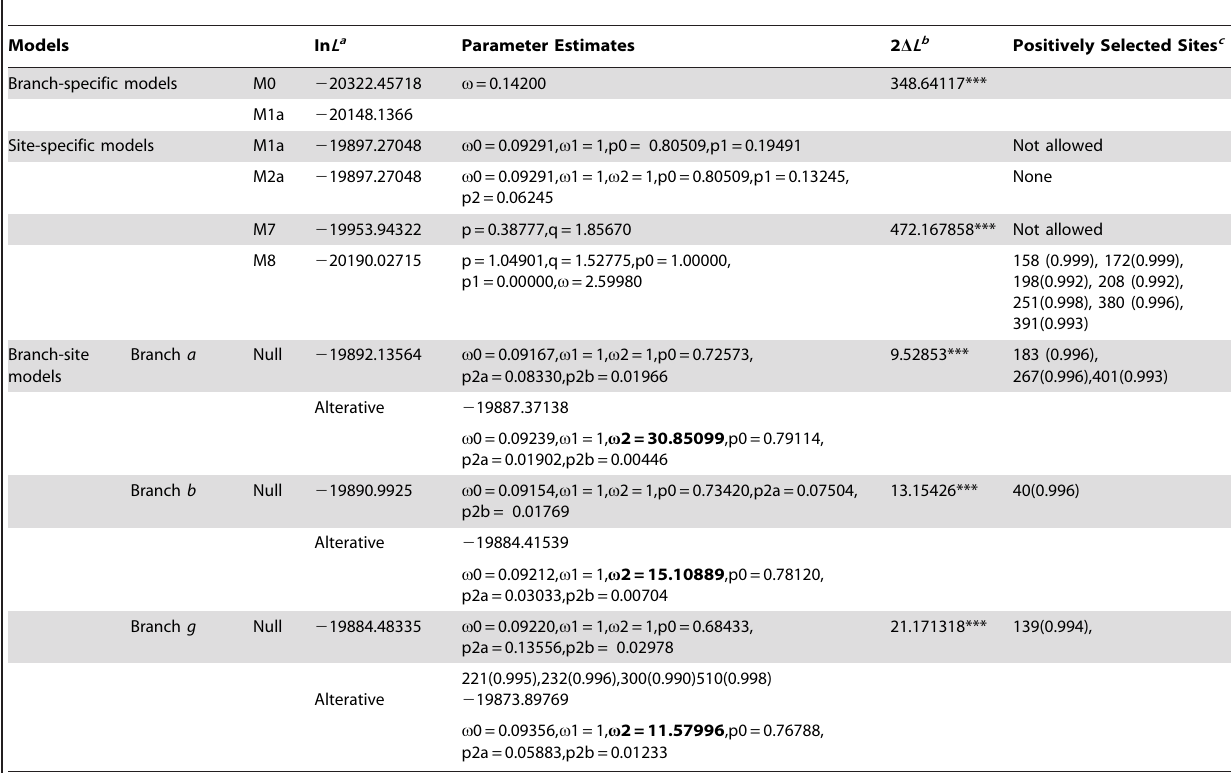
Table 3. CODEML analyses of selective pattern for M36 family